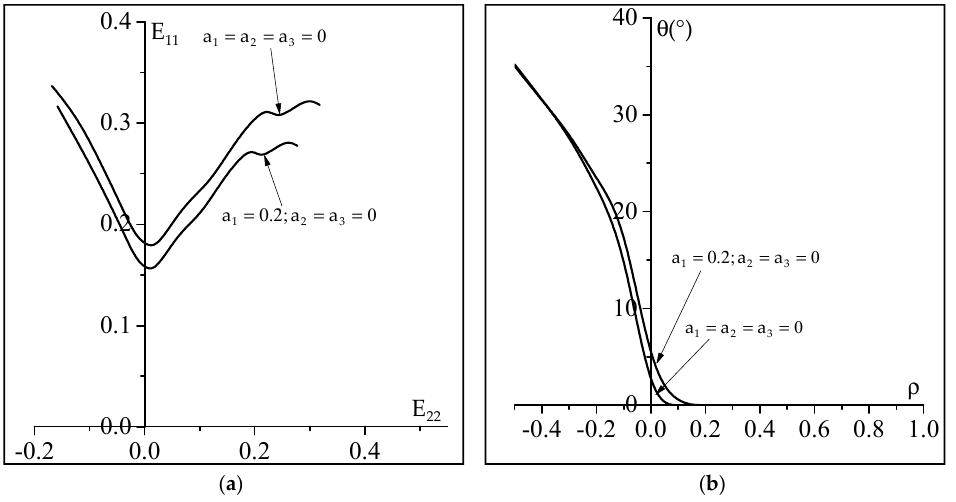
Figure 6. Impact of the non-Schmid effects on: ( a ) the shape and the level of the forming limit diagrams; ( b ) the evolution of the necking band orientation as a function of the strain-path ratio.